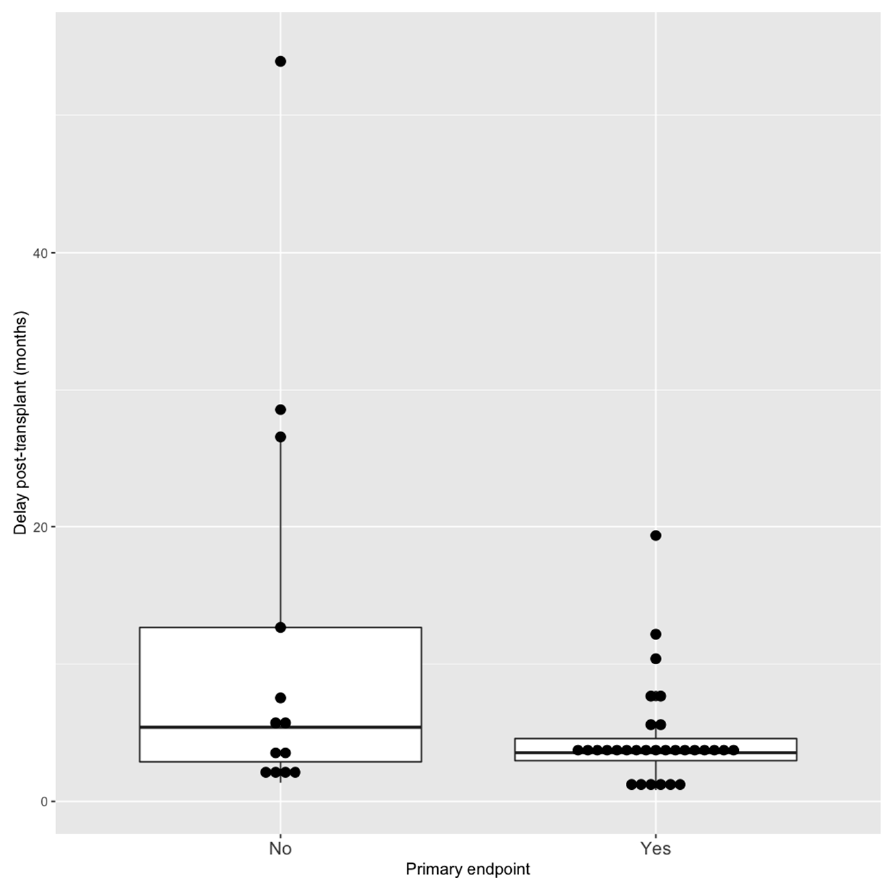
Figure 4. Comparison of the occurrence of BKV DNAemia post transplantation regarding to the primary endpoint (BKV clearance). Delay of viremia is reported in months. Boxplots are separated between those who did not reach the primary endpoint: “No” and those who cleared BKV DNAe- mia: